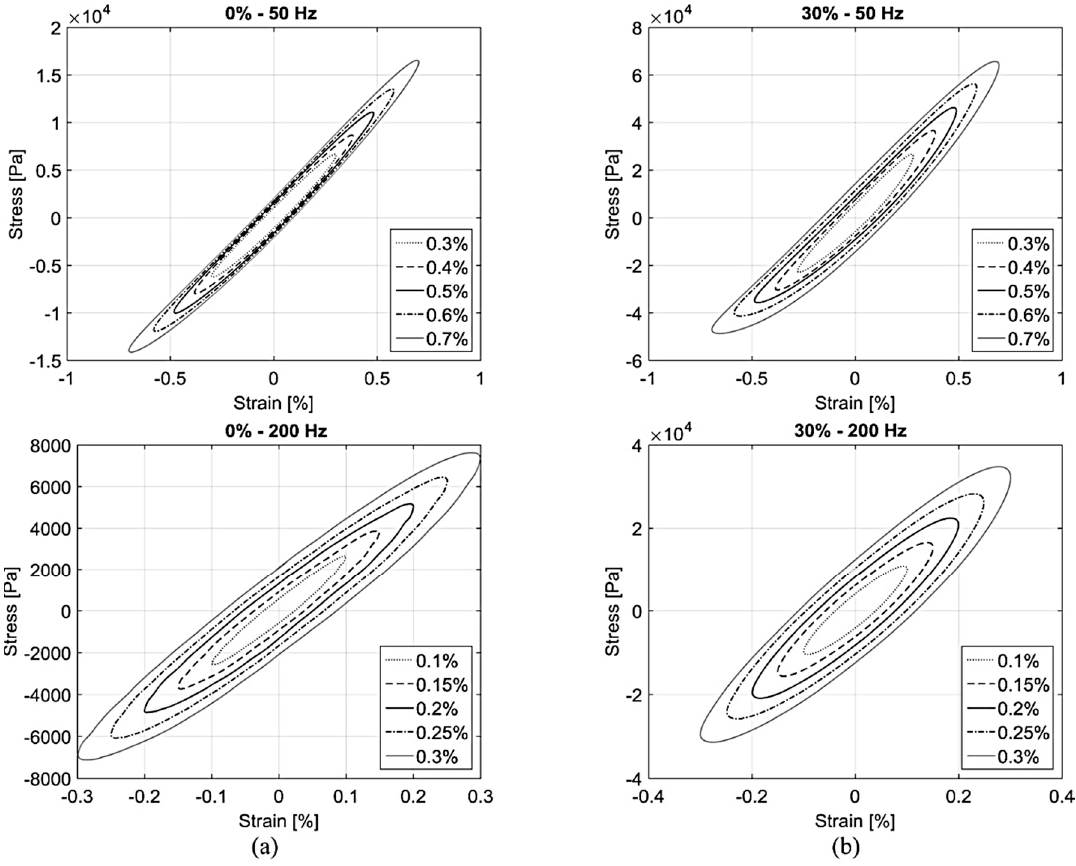
Figure 11. Stress–strain diagrams of MREs with CIPs concentration ( a ) 0% and ( b ) 30% under frequencies of 50 Hz and 200 Hz [27] (reprinted with permission from Elsevier TM ).